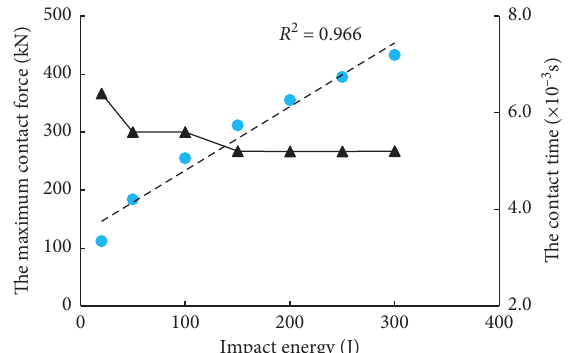
Figure 11: The maximum contact force (blue dot) and contact time (black triangle) vs. impact energy.